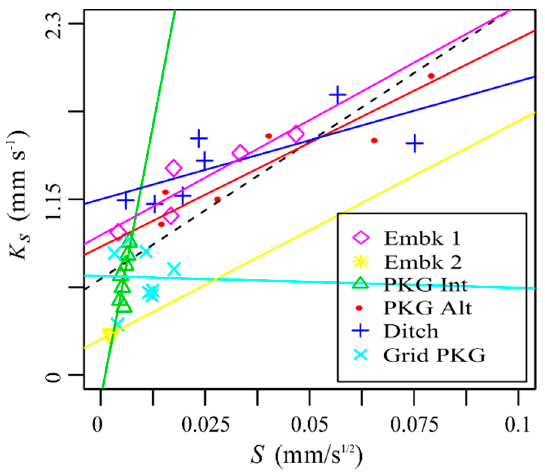
Figure 9. Mean K s vs mean S of the studied soils .